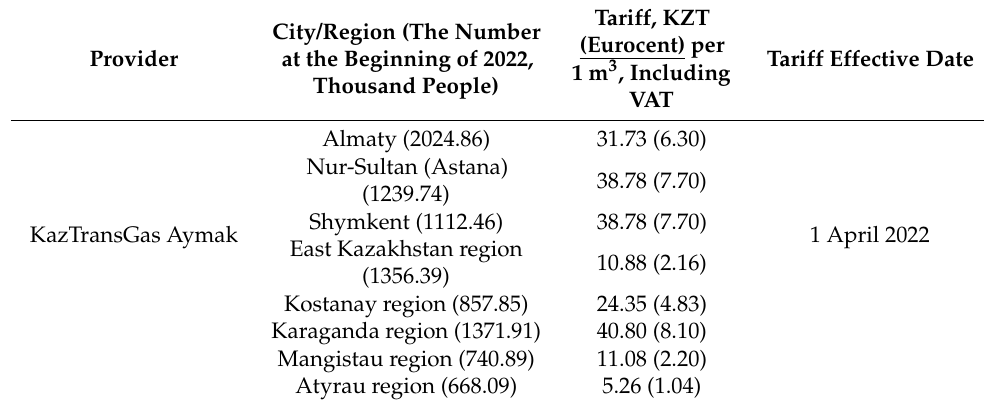
Table 3. Average tariff on gas for households by housing and public utilities (including the tariff for the transportation of marketable gas through gas distribution systems).